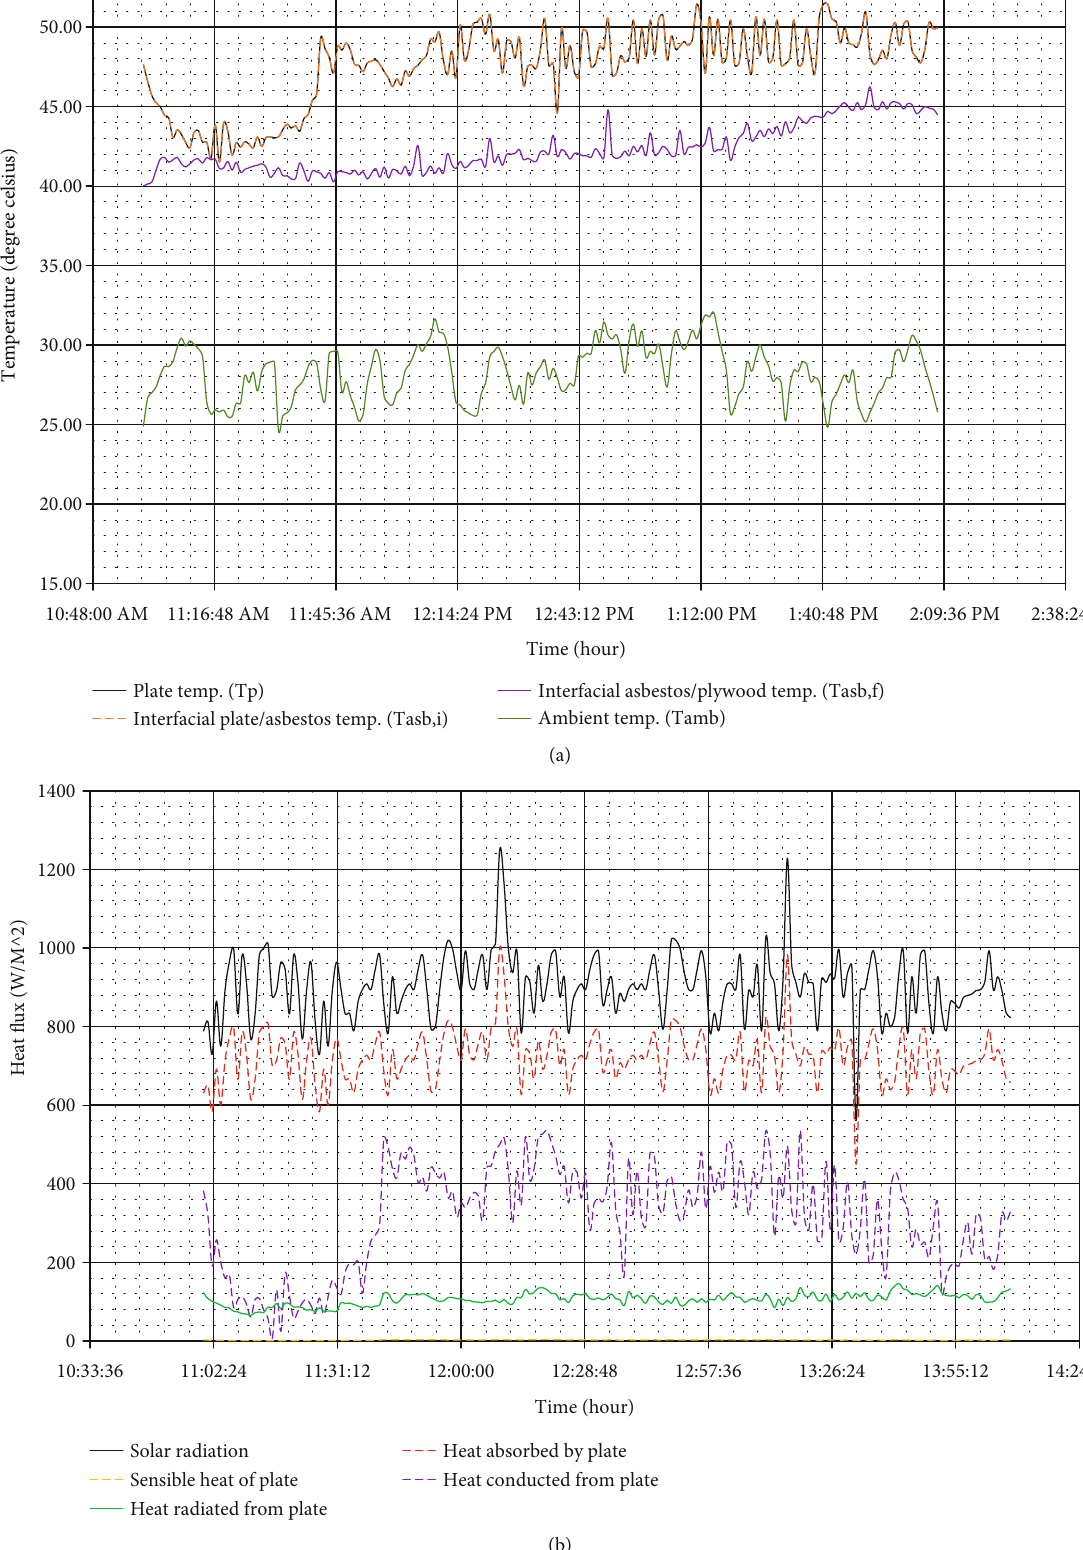
Figure 3: Plate heat fl ux performance (source: Authors,